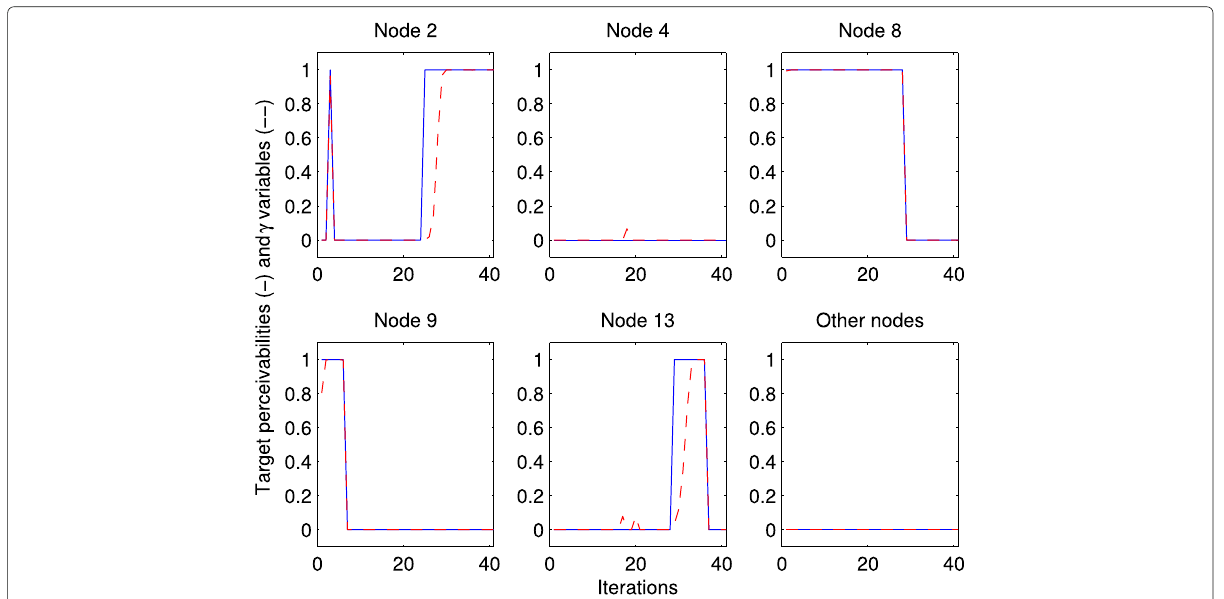
Fig. 7 Target perceivabilities and consensus scheme parameters corresponding to these